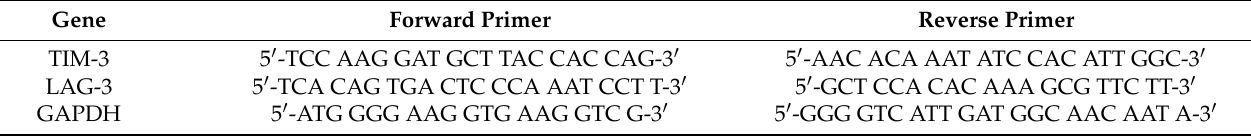
Table 8. List of primers used for PCR